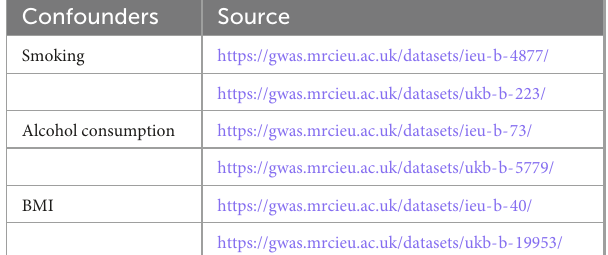
data analyzed in this study were obtained from publicly available databases in which ethical approval was obtained for each cohort, and informed consent was obtained from all participants prior to participation.